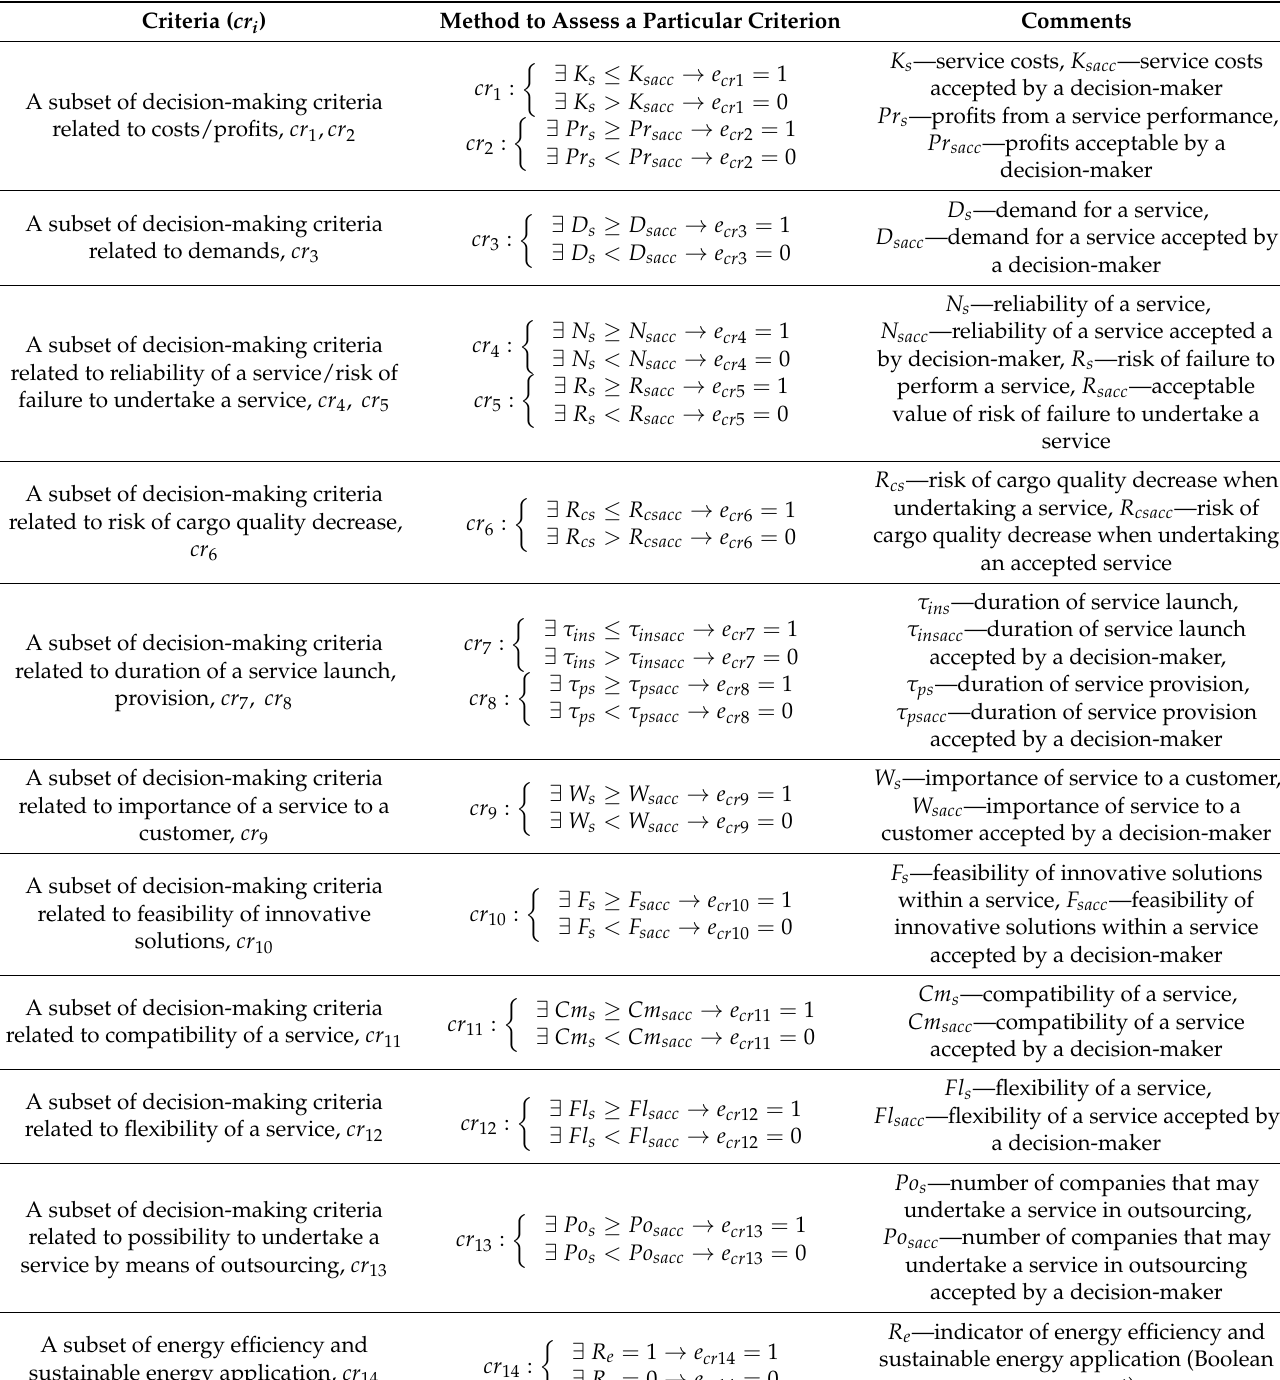
Table 2. Selected assessment criteria forming the evaluation